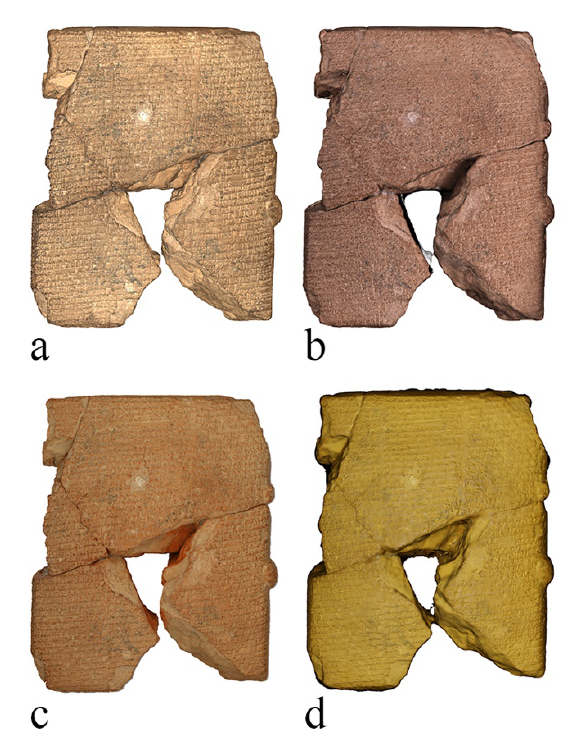
Figure 7. Textured 3D models of YBC 2178: a. structured light, b. triangulation laser scanner, c. photometric stereo, d. close- range